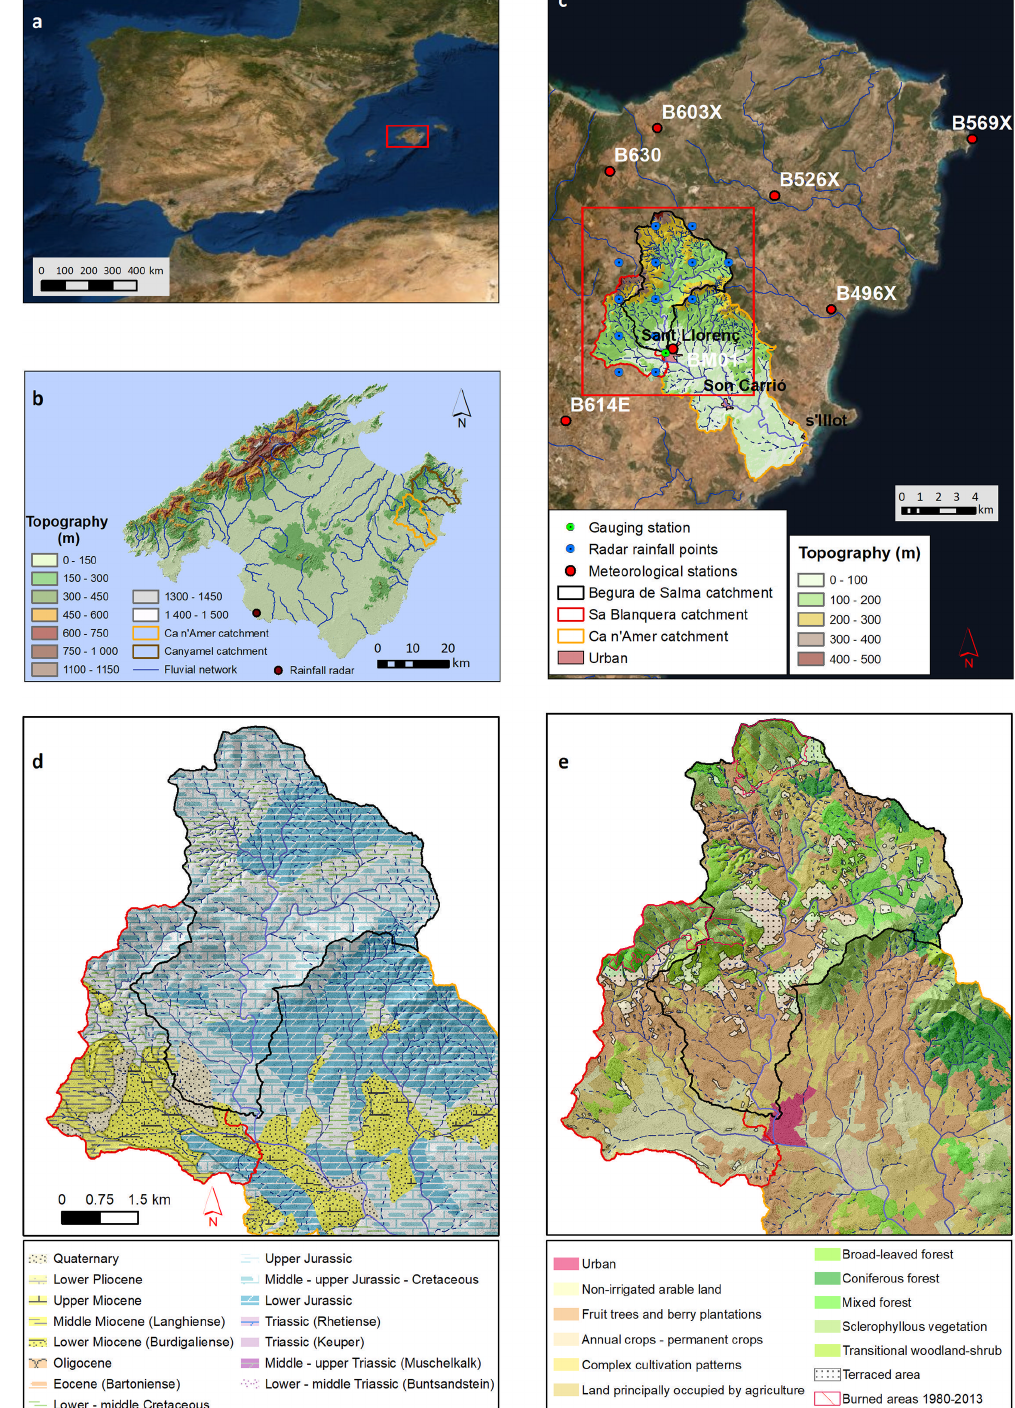
Figure 2. Main characteristics of affected basins during the 9 October 2018 flash flood. (a) Location of Mallorca in the western Mediter- ranean. (b) Topography and fluvial network of Mallorca with the location of the main basins affected: Canyamel and Ca n’Amer rivers. (c) Sa Blanquera and Begura de Salma headwater river catchments within the Ca n’Amer River, with locations of rainfall and hydrometric stations; and radar rainfall points derived from a regular mesh of 1 × 1km. Source: https://opendata.aemet.es (last access: 15 May 2020). Background: aerial photography and DTM data (PNOA, 2015). (d) Lithology of both the Sa Blanquera and Begura de Salma catchments. (e) Land use and terraced areas for the same headwater catchments. Source: Corine Land Cover